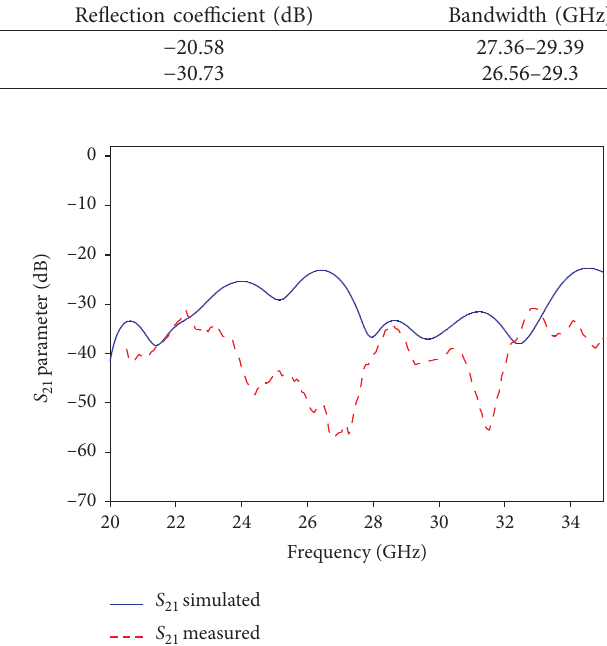
Figure 12: Simulated and measured transmission coefficients ( S 21) of the proposed MIMO